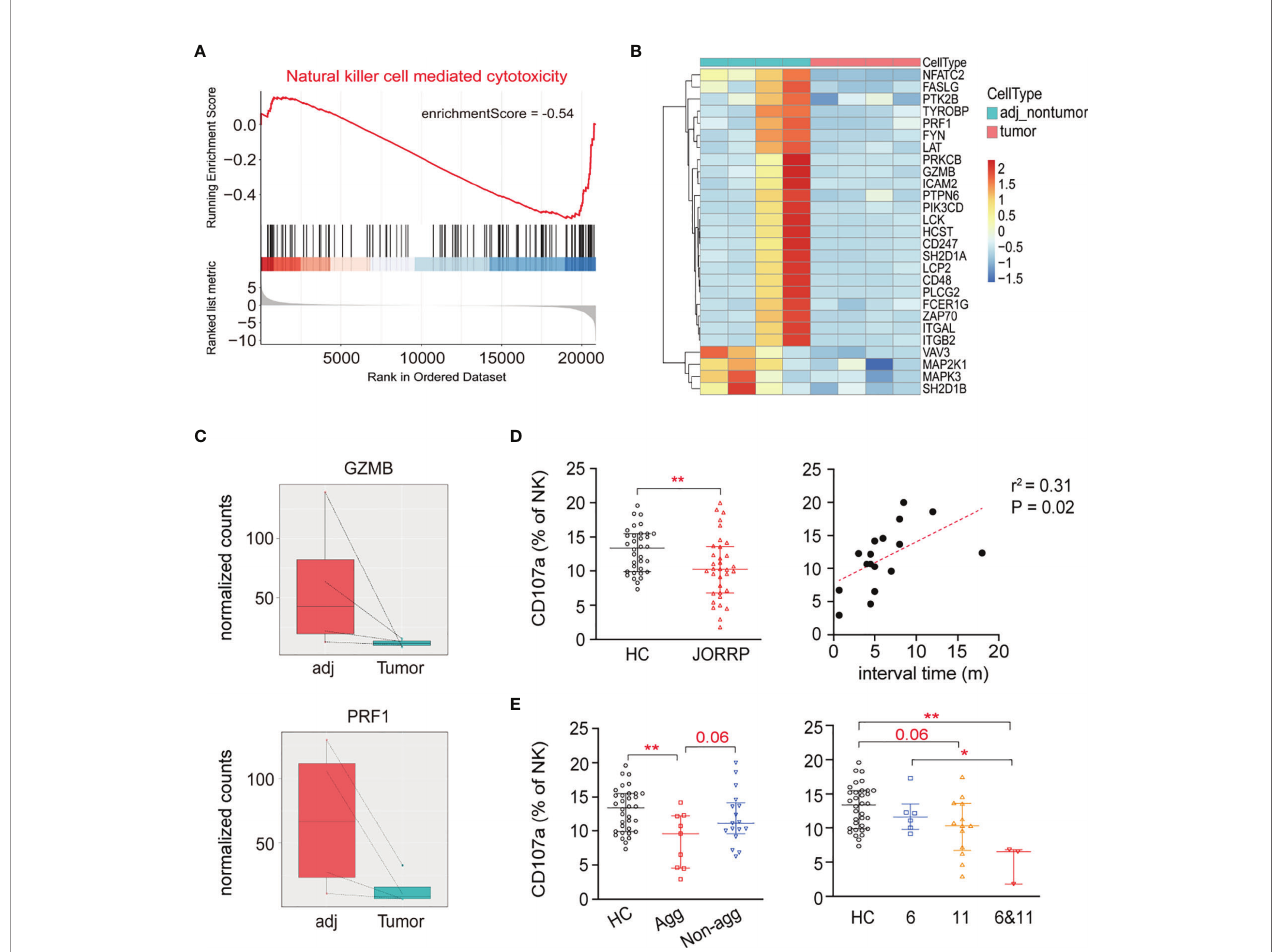
FIGURE 2 | Decreased NK cell cytotoxicity in JORRP patients. (A) The GSEA plot of natural killer cell-mediated cytotoxicity pathway downregulated in tumors of JORRP tissues. (B) The heatmap showing speci fi c expression of natural killer cell-mediated cytotoxicity pathway genes in JORRP tissues and paired adjacent nontumor tissues (n = 4). (C) Bar plots showing the normalized counts of GZMB and PRF1 genes in adjacent nontumor tissues (adj) and tumor tissues. (D) Percentage analysis CD107a expression on NK cells determined by fl ow cytometry of HCs (n = 34) and JORRP patients (n = 34). Correlation of CD107a expression on NK cells with interval time of surgical reoccurrence. Spearman ’ s correlation coef fi cients are shown. m, months. (E) Percentage analysis of CD107a expression on NK cells determined by fl ow cytometry of HCs and different subgroups of JORRP patients. HCs, healthy controls (n = 34); Agg, aggressive (n = 9); Non-agg, non- aggressive (n = 17); 6, HPV6 (n = 6); 11, HPV11 (n = 13); 6&11, HPV6&HPV11 (n = 3). Data are presented as median with interquartile range. Each dot represents a single patient. ns, not signi fi cant; *P < 0.05; **P <